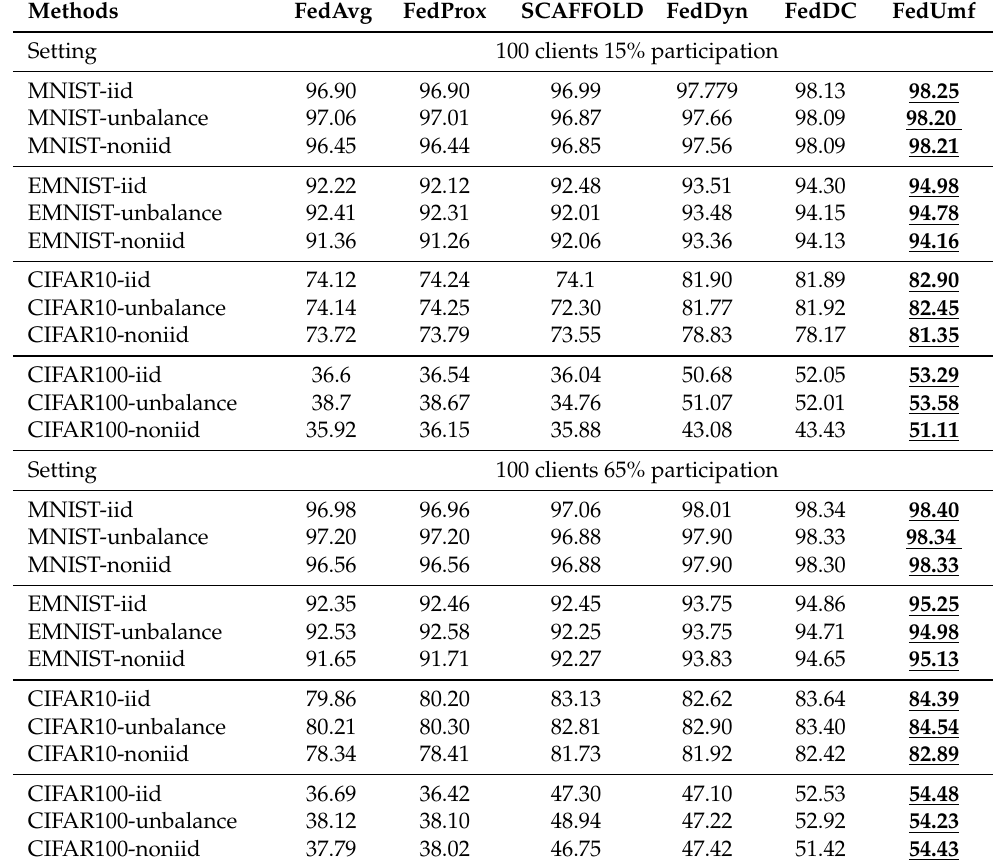
Table A1. The test accuracy (%) on IID, non-IID, and unbalanced data for partial client participation (15% and 65%). “ ACCURACY ” is recorded as first